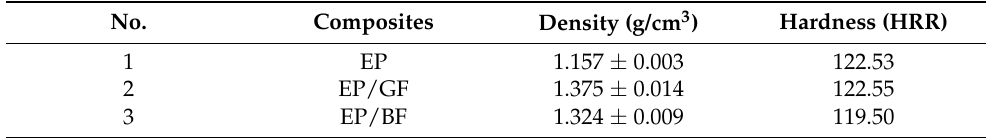
Table 2. Density and hardness of the